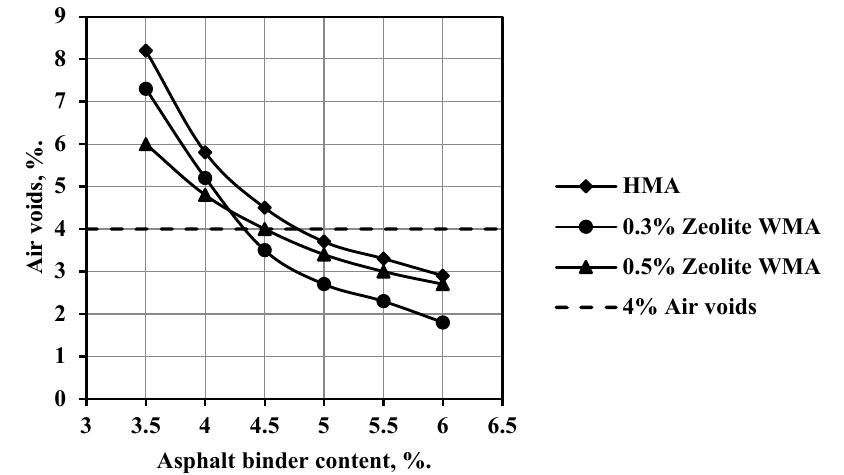
Figure 3. Optimum asphalt binder content for 4% air voids.